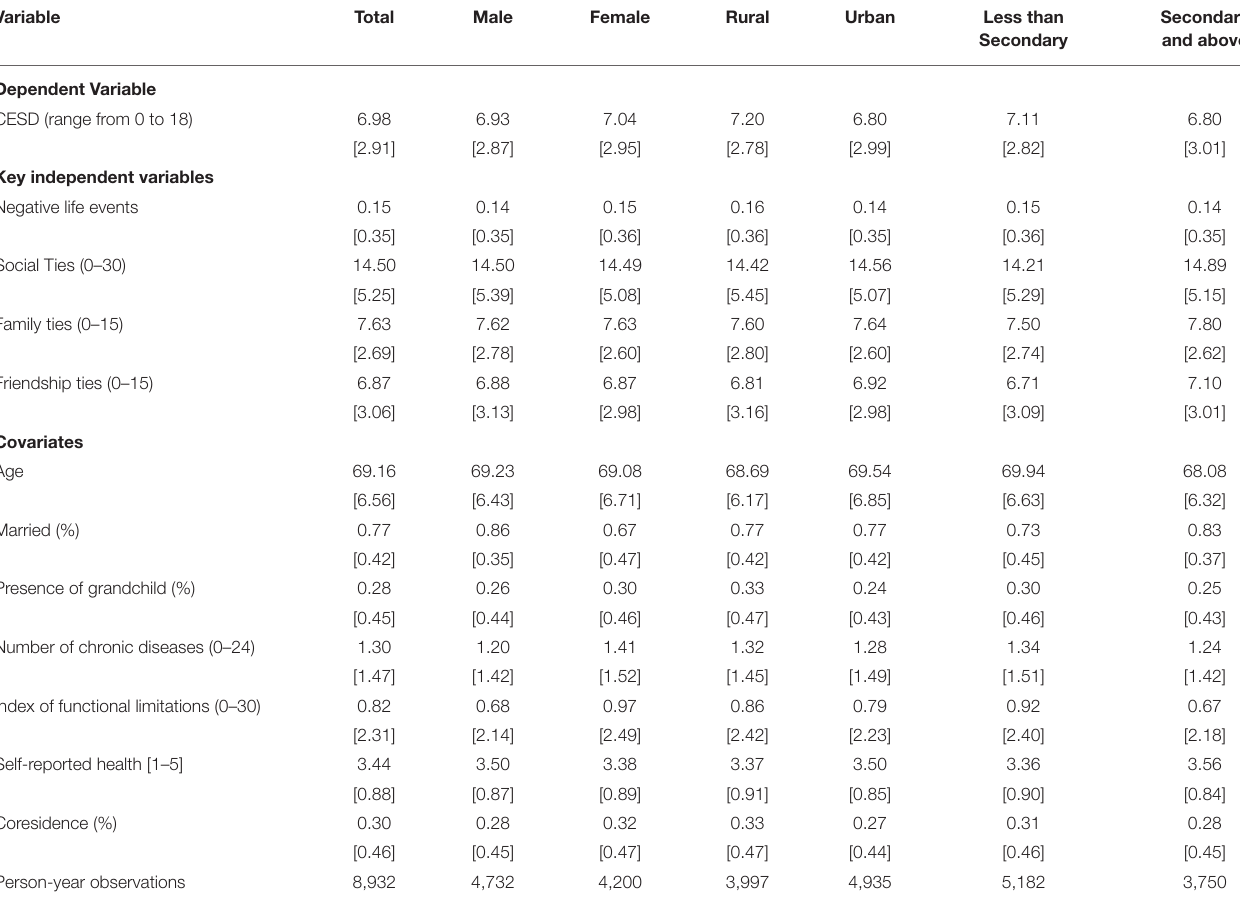
The mean values (or percentage) are presented, with standard deviation in the